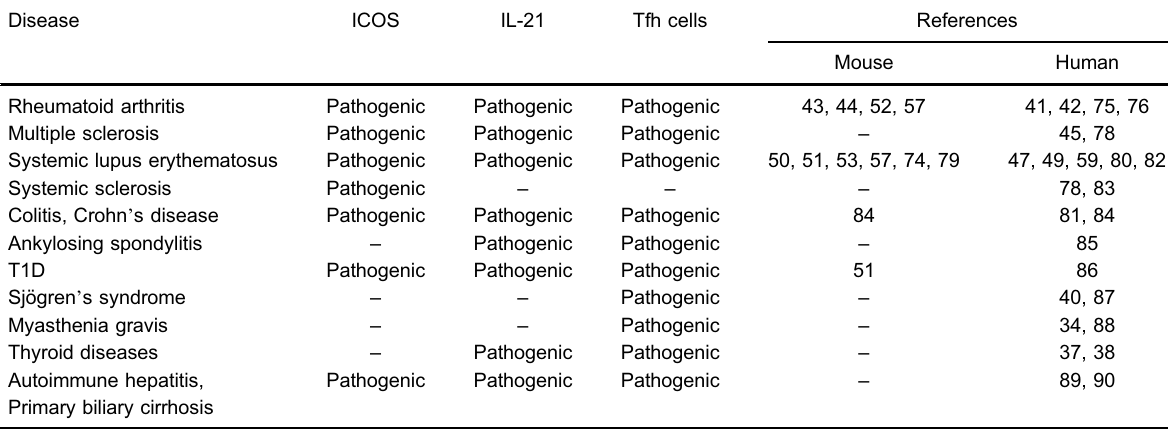
Table 1. In fl uence of follicular helper T cells (Tfh) in human and mouse diseases.